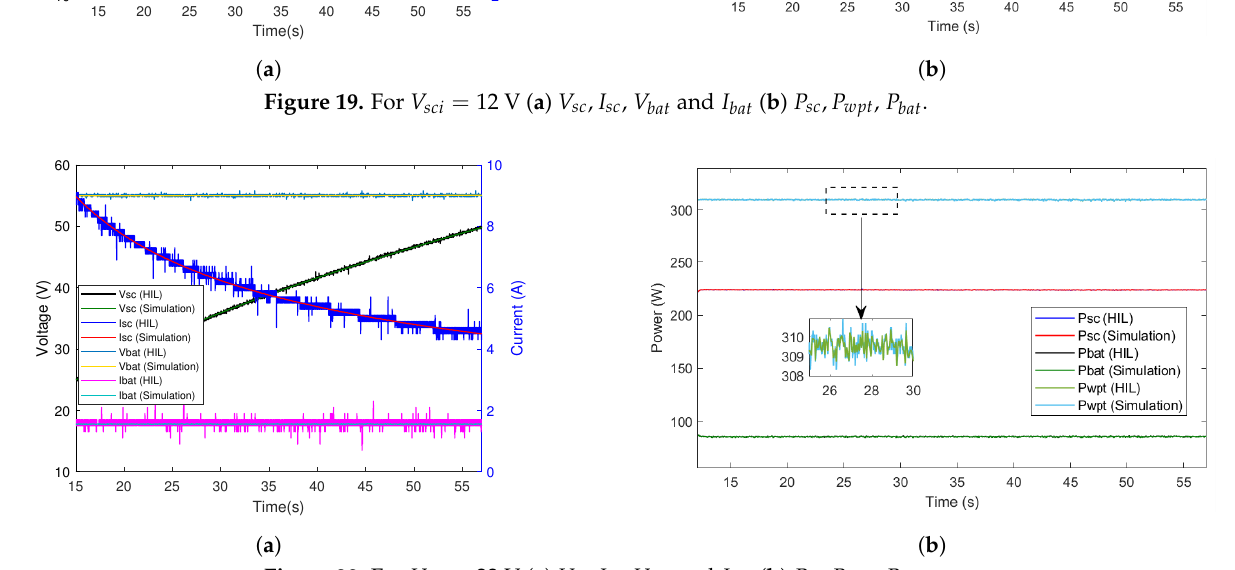
Figure 20. For V sci = 22 V ( a ) V sc , I sc , V bat and I bat ( b ) P sc , P wpt , P bat